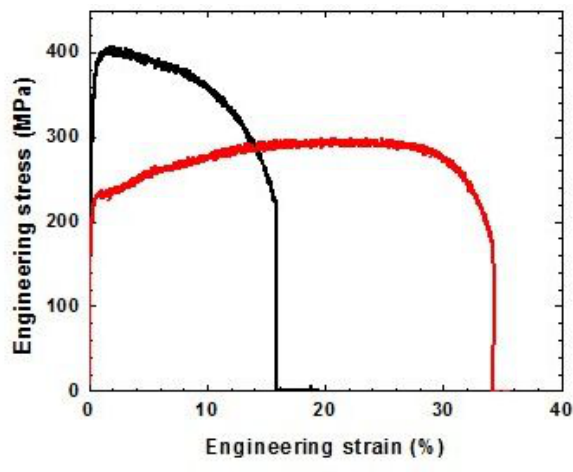
Figure 2: Tensile engineering stress-strain curves of as-ECAP (black) and bimodal Cu (red).